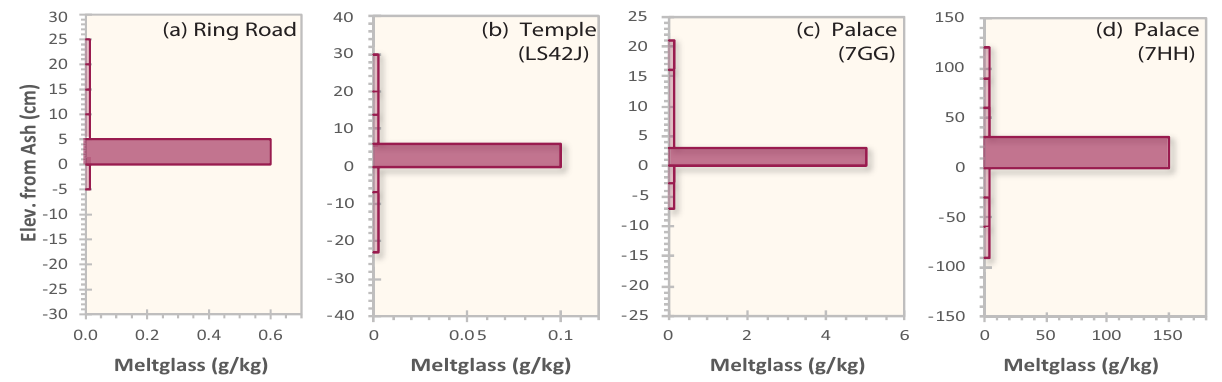
Figure 12. Meltglass: melted pottery, mudbrick, and roofing material. ( a )–( d ) Meltglass from 3 sites; no meltglass was found in the wadi and none was found above or below the destruction layer. Depths are in cm above or below the bottom of the destruction